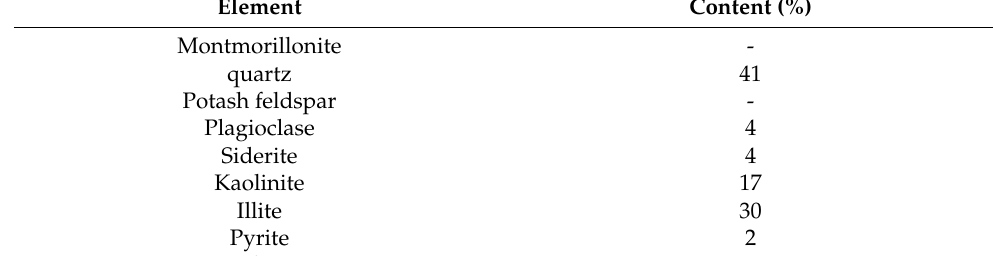
Figure 2. Gangue XRD test results.